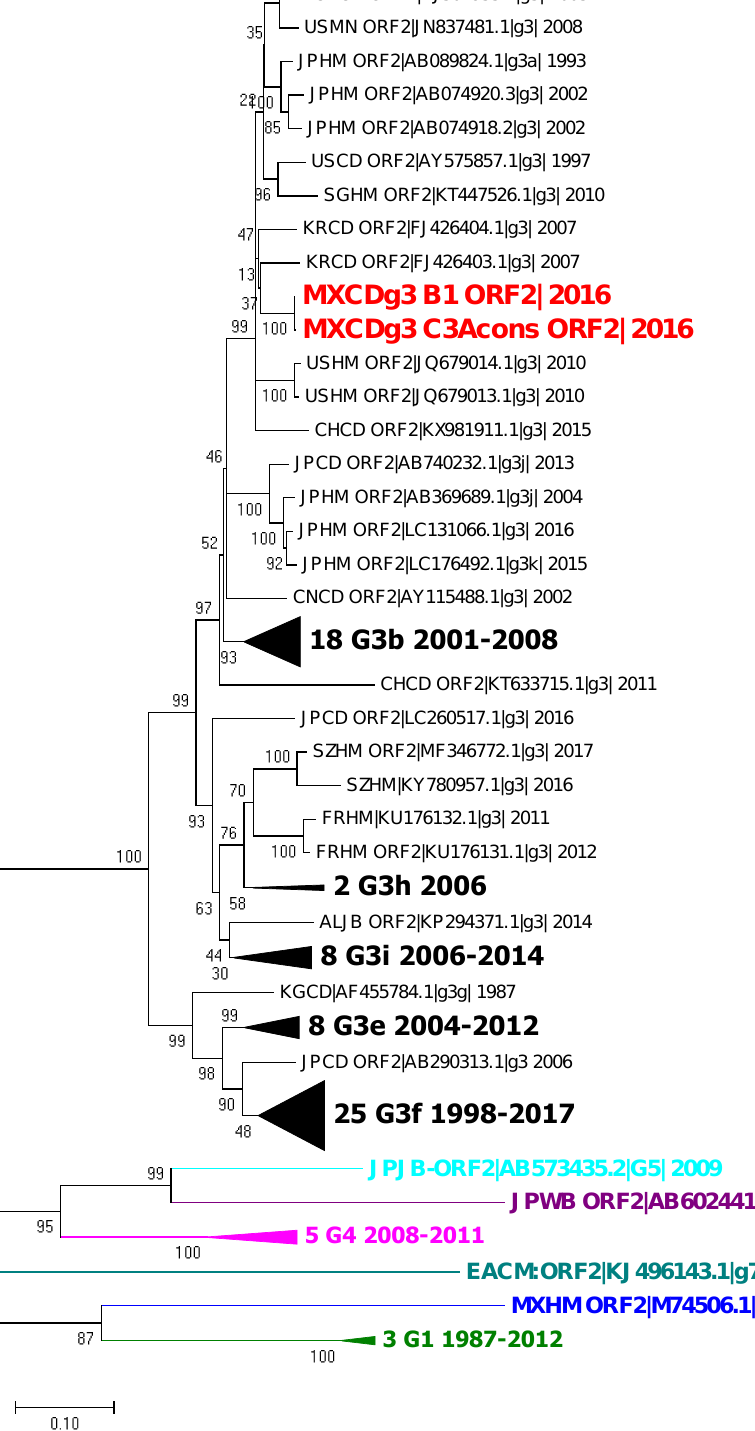
Figure 3. Phylogenetic tree of the ORF2 sequences of HEV. Analysis included 102 nucleotide sequences (CD-HIT 98%). Relationship was inferred by the maximum likelihood method based on the GTR model with gamma distribution and 1000 bootstrap. Branches were clustered to construct the graph. The first number indicates number of sequences, genotype and subgenotype, and year of detection. Black triangles symbolize clustering of similar sequences identified by number of sequences, genotype and years of report. Colors represent different genotypes, blue for genotype 2, green for genotype 3, magenta for genotype 4, cyan for genotype 5, purple for genotype 6 and light blue for genotype 7.